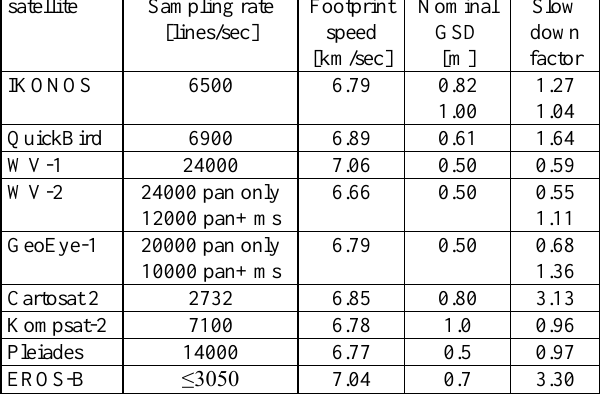
Table 2. Sampling rate and slow down factor